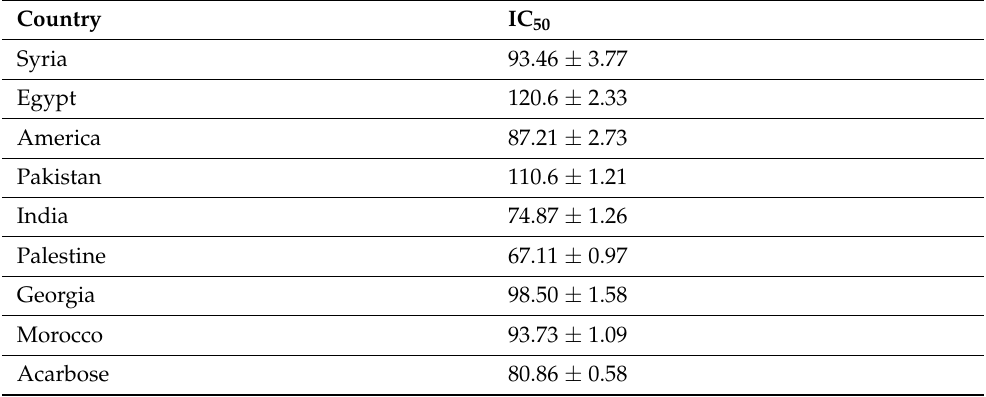
Table 3. α -Amylase inhibitory activity of the selected extracts (IC 50 ± SD µ